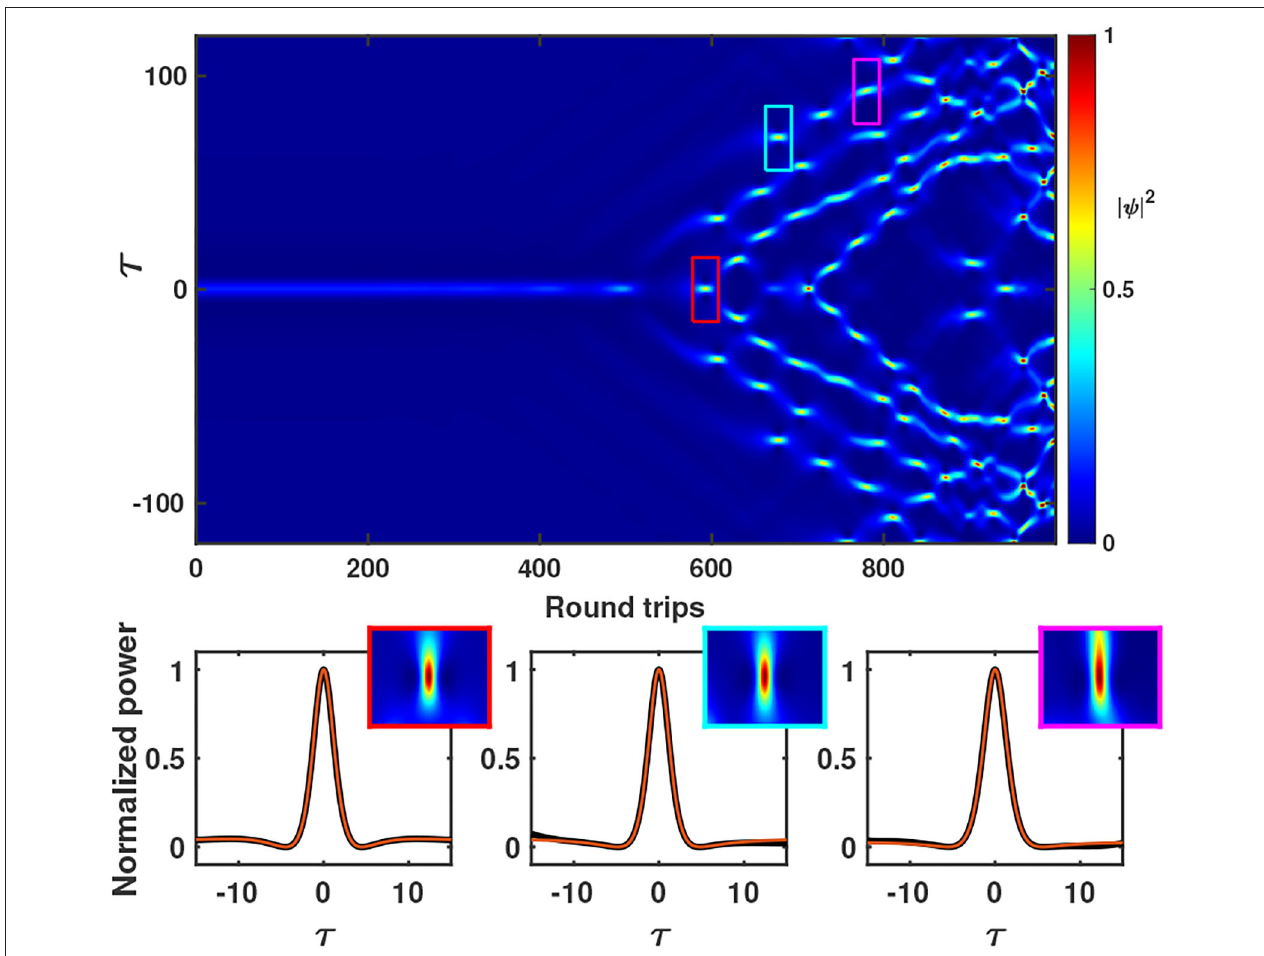
10 − 5 , δ 5 10 − 2 , and S 4.3 10 − 3 . The bottom panels show the = = × = ×